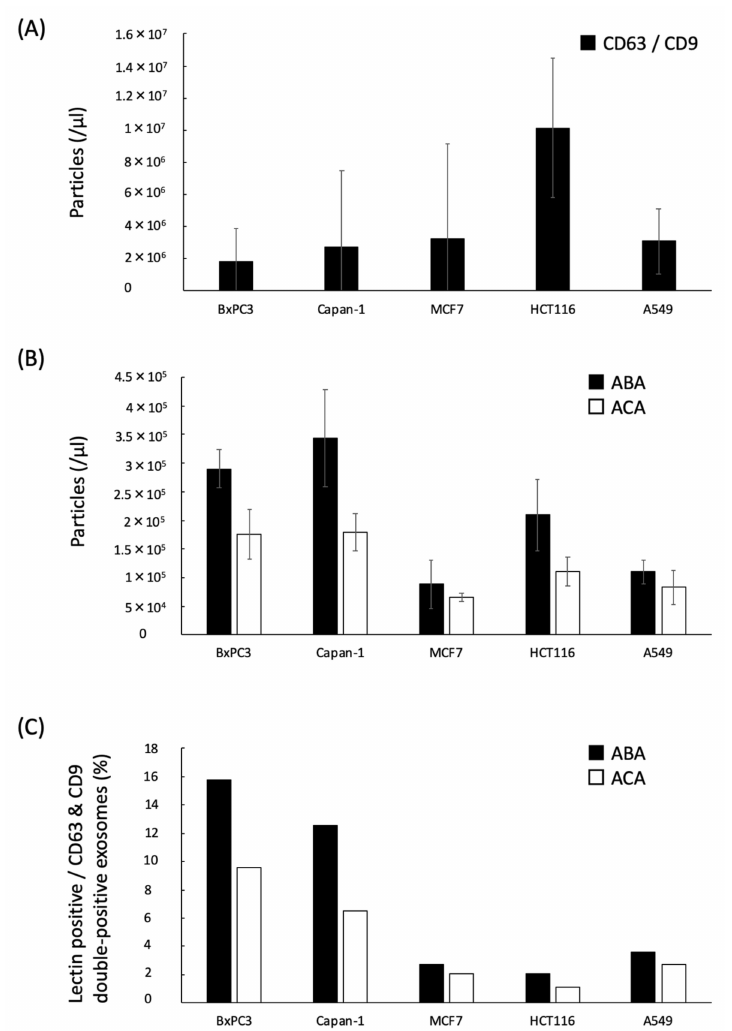
Figure 4. EVs derived from cancer cell cultures using ABA and ACA. EVs in the culture media with BxPC3, Capan-1, MCF7, HCT116, and A549 cells were quantified with ExoCounter. ( A ) Total EV detection using anti-CD63 Ab-coated disc and anti-CD9 Ab-conjugated beads. ( B ) Lectin-binding EV detection using the ABA- or ACA-coated disc and anti-CD9 Ab-conjugated beads. ( C ) Percentage of the ABA- or ACA-positive EVs normalized to CD63 / CD9-positive EVs. Data are presented as means ± SD ( n =